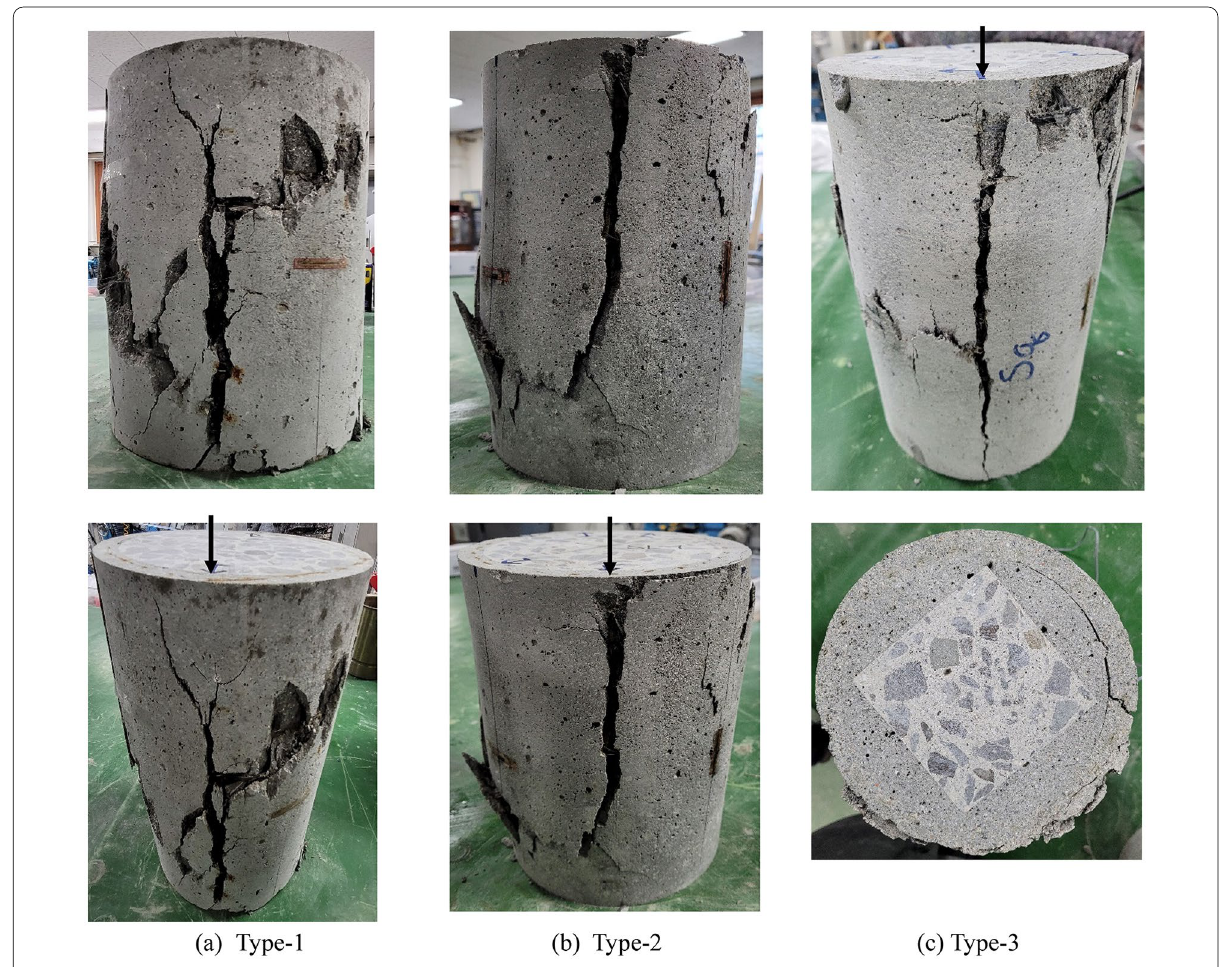
Fig. 16 Specimens after test: crack patterns. a Type-1, b Type-2, c Type-3